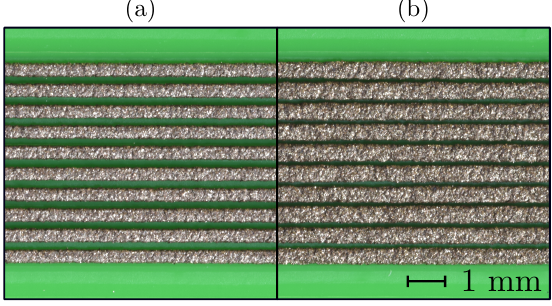
Figure 5. Nozzle temperature T nozzle influence: ( a ) T nozzle = 100 ◦ C, ( b ) T nozzle = 200 ◦